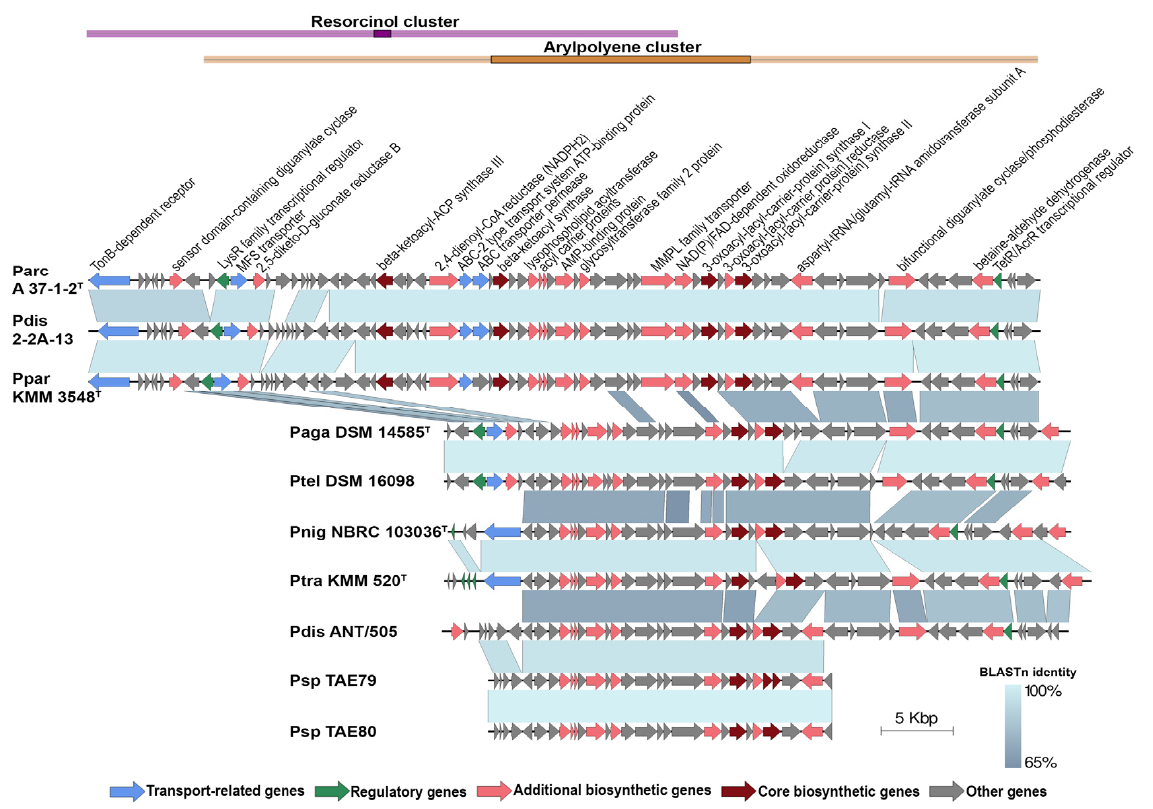
Figure 7. Comparative analysis of synteny between resorcinol and/or aryl polyene biosynthetic gene clusters ( ape BGC) , which were found in ten Pseudoalteromonas genomes: Parc A 37-1-2 T , P. arctica A 37-1-2 T ; Pdis 2-2A-13, P. distincta 2-2A-13; Ppar KMM 3548 T , P. paragorgicola KMM 3548 T ; Paga DSM 14585 T , P. agarivorans DSM 14585 T ; Ptel DSM 16098, “ P. telluritireducens ” DSM 16098; Pnig NBRC 103036 T , P. nigrifaciens NBRC 103036 T ; Ptra KMM 520 T , P. translucida KMM 520 T ; Pdis ANT/505, P. distincta ANT/505; Psp TAE79, Pseudoalteromonas sp. TAE79; Psp TAE80, Pseudoalteromonas sp. TAE80. Genes were colored based on their annotations, as indicated at the bottom of the figure.